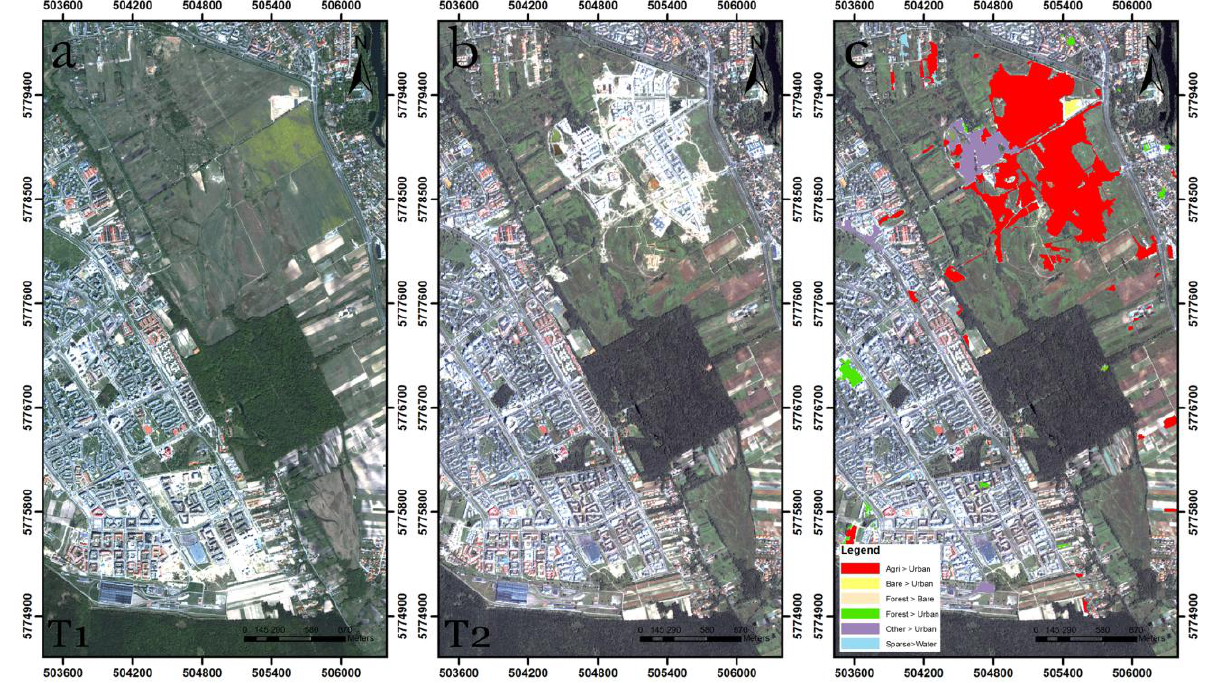
Figure 6. IKONOS image from 2002 ( a ) and IKONOS image from 2008 ( b ) with a change type layer overlaid on image T2 ( c ); subset of the Warsaw test